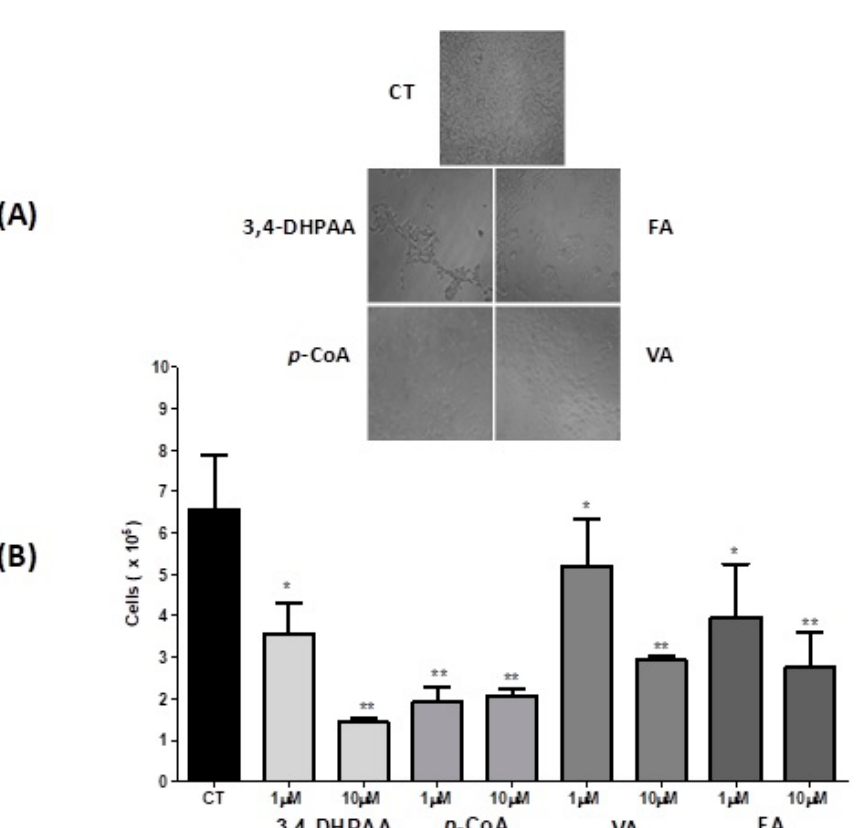
Figure 1. Effect of 3,4-DHPAA, p -CoA, VA and FA (100 µ M) on HT-29 cells 24 h after incubation ( A ). Effect of 3,4-DHPAA, p -CoA, VA and FA on cell viability (mean ± SD) (HT-29) 24 h after incubation ( B ). Significant differences between the untreated cells (CT) and those incubated with the respective acids (1.0 µ M and 10.0 µ M) were compared by the one-way ANOVA test, with Tukey post-test (* p < 0.05; ** p < 0.01).